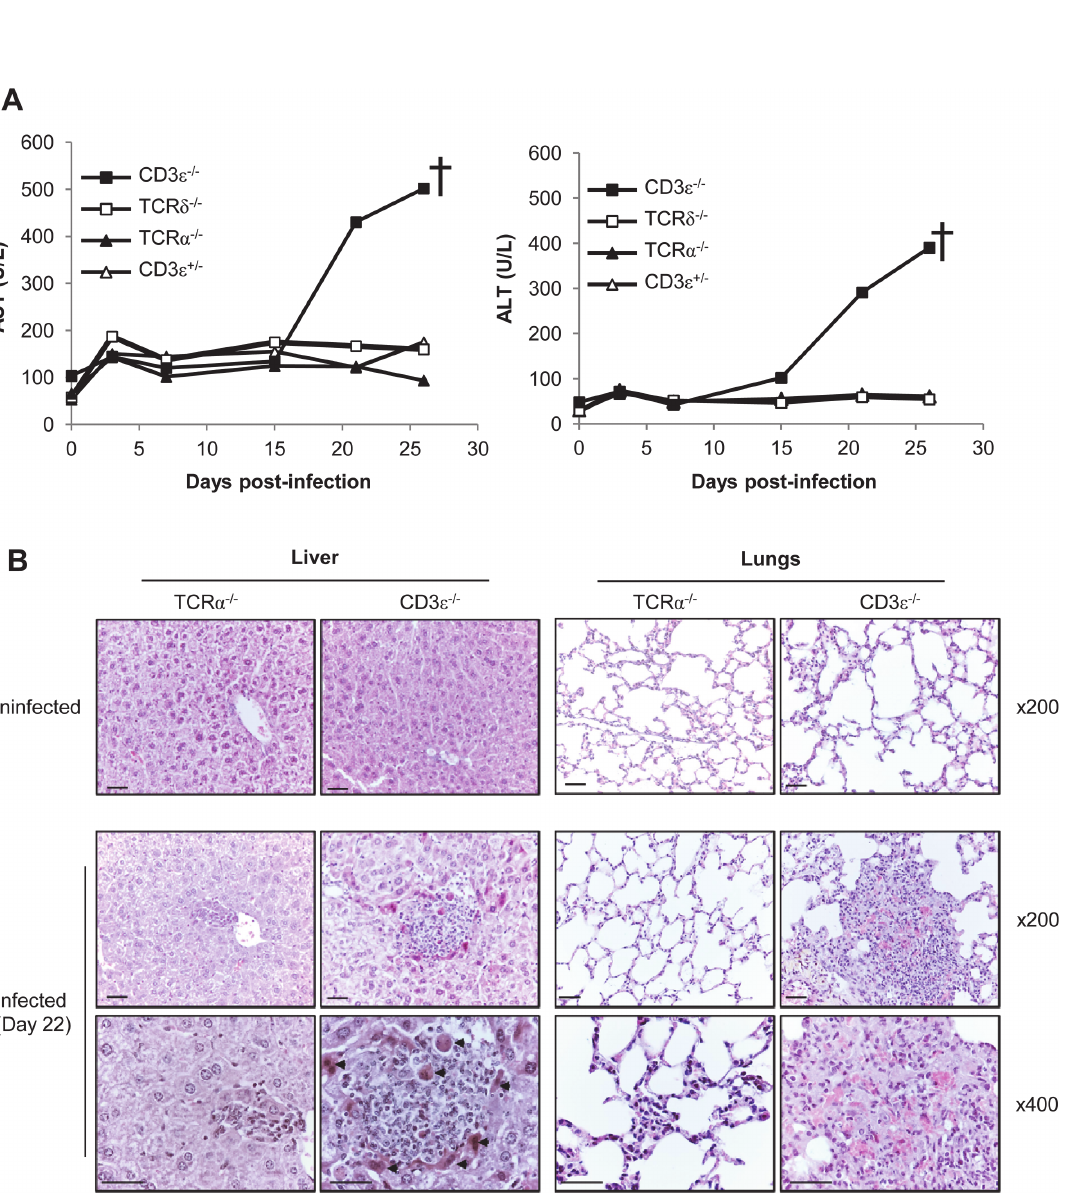
Fig 3. γδ T cell control of MCMV infection is associated with reduced organ damage. A. TCR δ − / − , TCR α − / − , CD3 ε +/ − and CD3 ε − / − mice were infected i.p. as indicated in Fig. 1A. 3 mice/group were bled at days 0, 3, 7, 15, 21 and just before death for biochemical analyses of AST and ALT in serums. The experiment was repeated twice and data obtained for one representative mouse/group are shown. † death of CD3 ε − / − . B. TCR α − / − and CD3 ε − / − mice were uninfected, or i.p. infected with 2.10 3 pfu of MCMV. Uninfected and Day 22-infected mice were sacrificed and the liver and lungs were embedded in paraffin for HES staining. Apoptotic hepatocytes are shown (arrowheads). Scale bar = 200 mm. Magnifications are indicated in the right-hand side of the figure. The data are from one representative of 3 mice for each